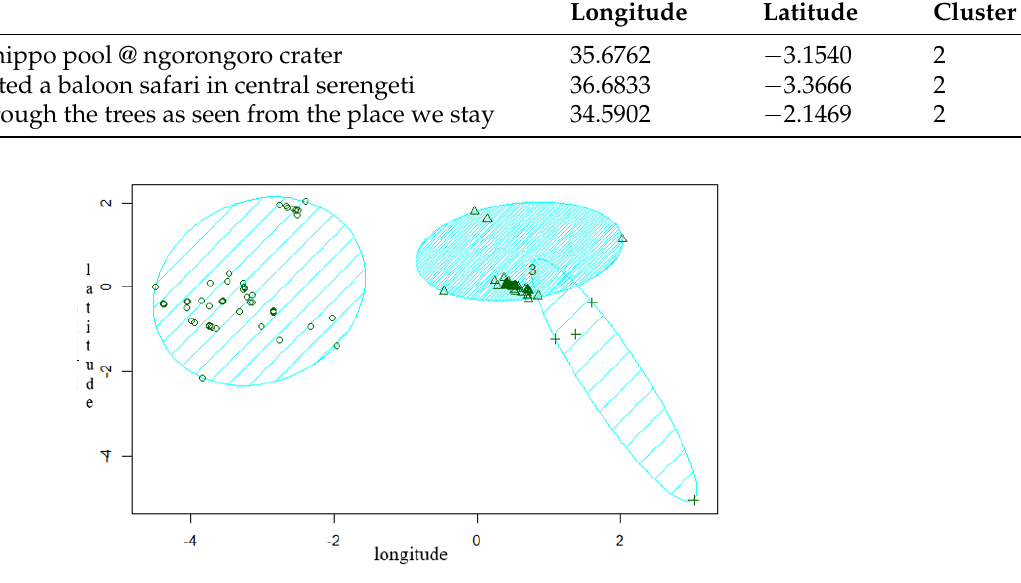
Figure 4. Clusters of geotagged